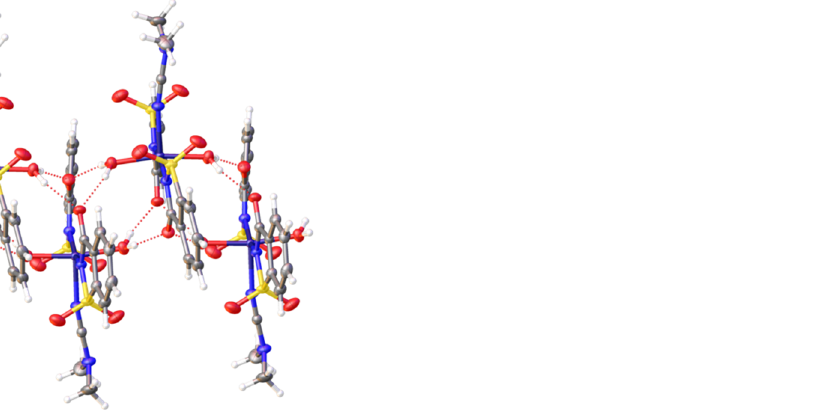
Figure 2. A fragment of crystal packing of 1 with the inter-ligand hydrogen bonds shown in dotted lines.